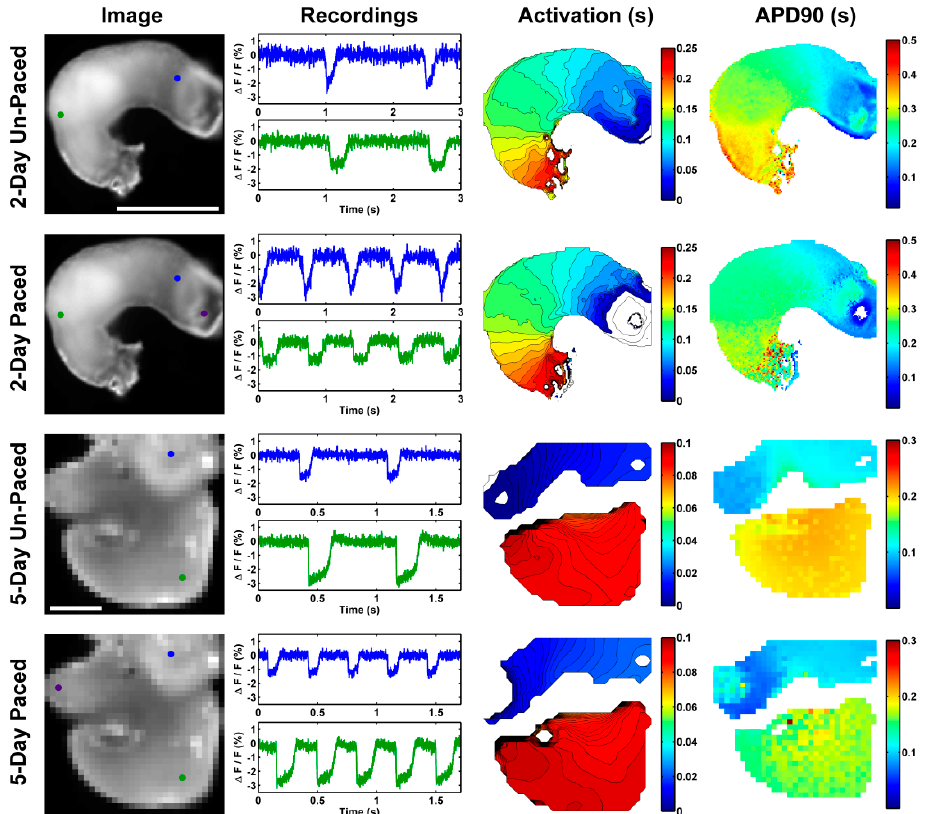
Figure 10. Optical pacing combined with optical mapping. Representative data from 2-day (HH stage 15), with no binning ( A , B ), and 5-day (HH stage 27), with 4 × 4 binning ( C , D ), excised embryonic quail hearts. Fluorescence images of the hearts (Image) have a blue dot on the atrioventricular junction (2 day) or atrium (5 day) and a green dot on the ventricle. The purple dot indicates the position of the pacing laser ( B , D ). Scale bars are 500 µm. Representative recordings of electrical activity are shown for the matching colored markers. Activation maps (Activations(s)) are shown with the color map in seconds and the isochrones are 10 ms apart for the 2-day heart ( A , B ) and 1 ms apart for the 5-day heart ( C , D ). Action potential duration maps [APD90 (s)] are shown with the color map in seconds. [245].